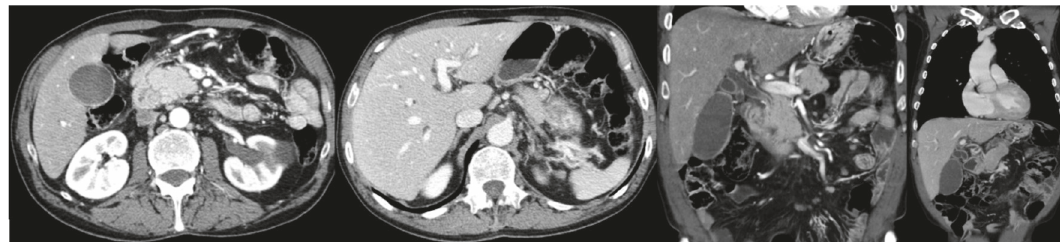
Figure 3: Cervical-thoracic-abdominal-pelvic computed tomography revealed parietal contrast enhancement without intraluminal well- defined mass at the distal common bile duct level with upstream dilatation of the extrahepatic and intrahepatic bile ducts.